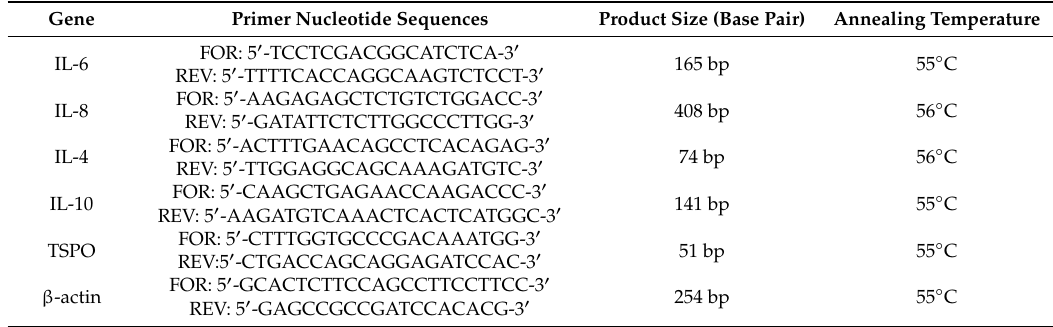
Table 1. Nucleotide sequences, product size, and annealing temperature of the primers utilized in real-time RT-PCR